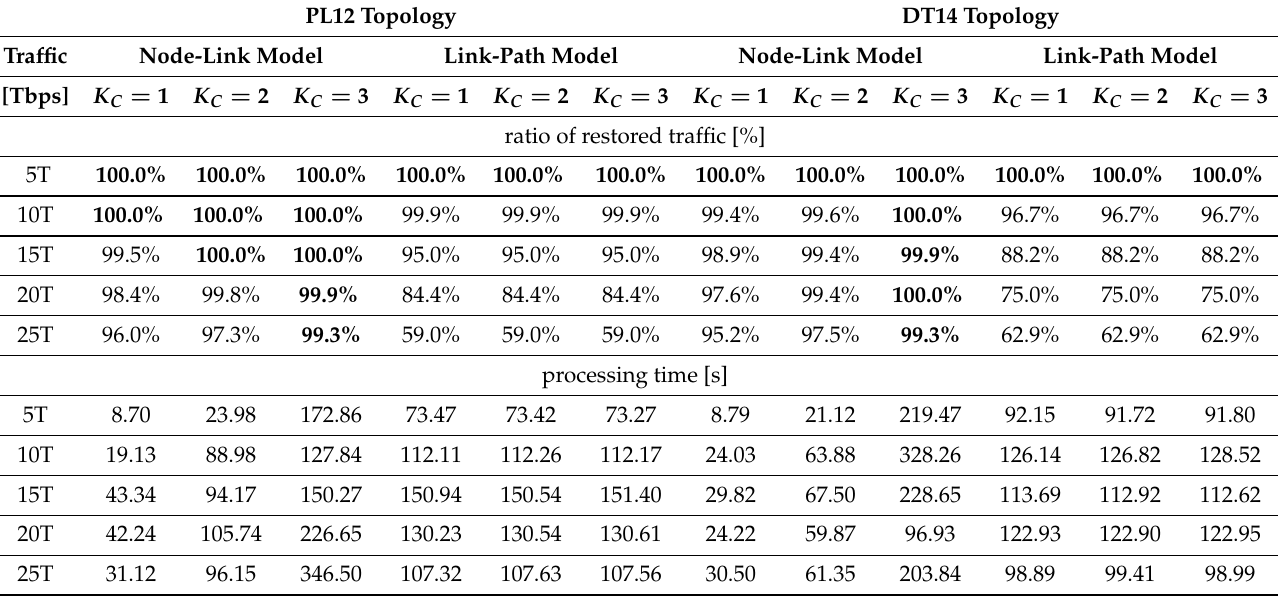
Table 6. Comparison of the node-link and the link-path models for the traffic restoration problem for ρ = 1.4: the average ratio of the restored traffic [%] and the processing time [s] (for each topology and traffic volume, the best result is bold). PL12 Topology DT14